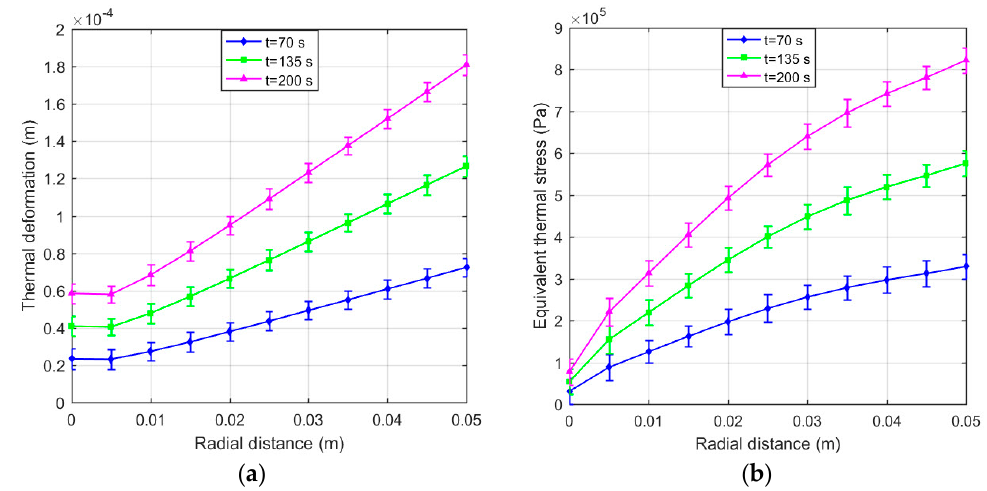
Figure 12. Thermal deformation and equivalent thermal stress of MRFs of the disc ‐ type MRC along the radial working gap. ( a ) Thermal deformation; ( b ) Equivalent thermal stress.